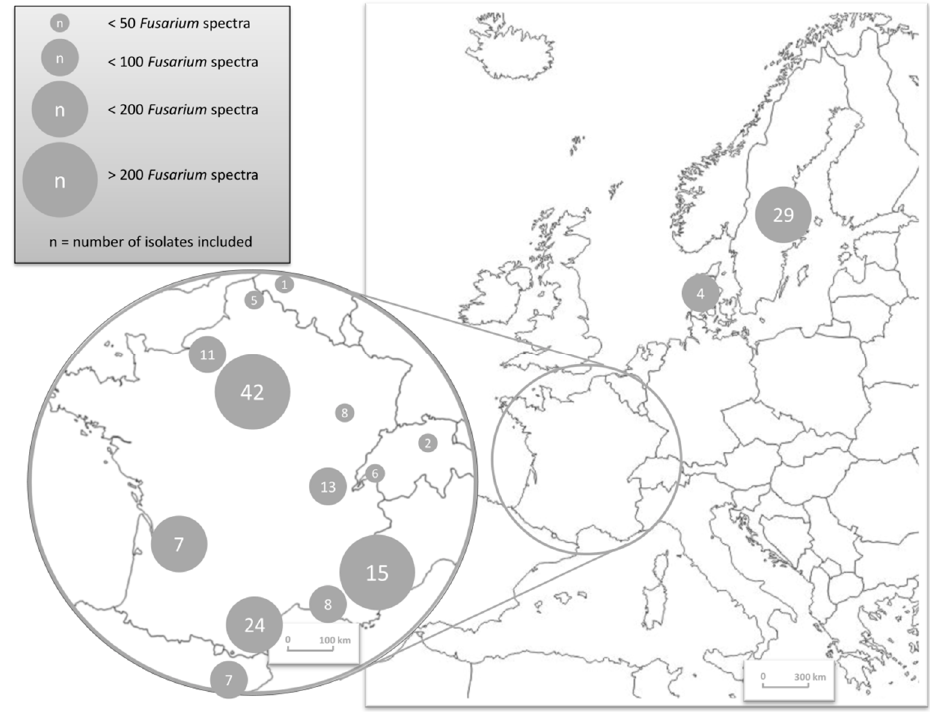
Figure 1. Geographical repartition of the 20 participating centers, and respective contribution to the project as indicated by the number of spectra sent to the Mass Spectrometry Identification (MSI) database.